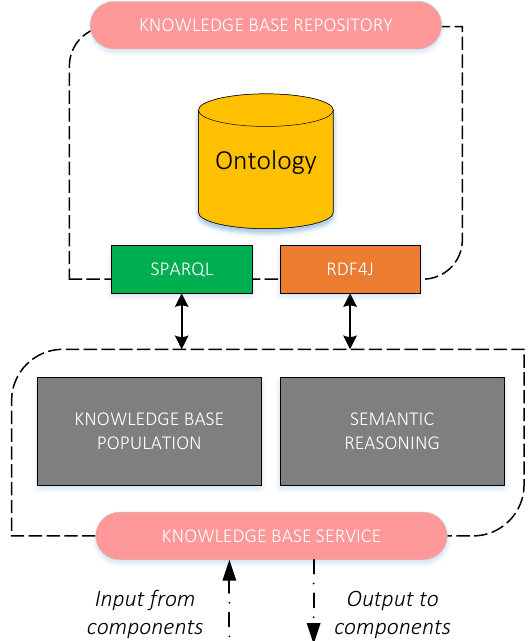
Figure 2. The semantic